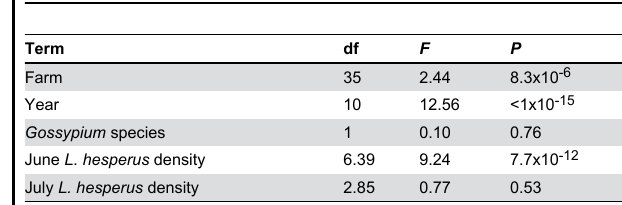
Table 1. Generalized additive model of factors associated with early-season (June) retention of flower buds by cotton.